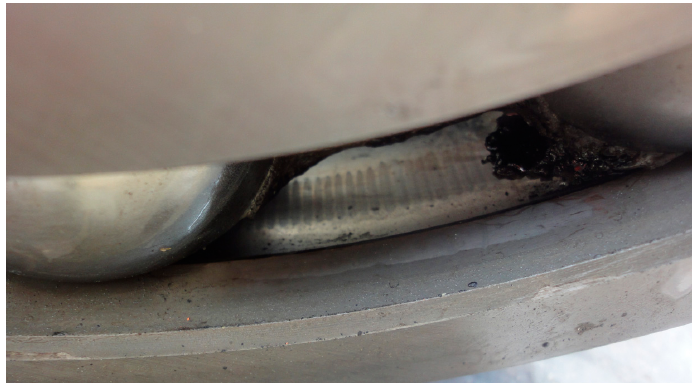
Figure 14. Electric corrosion of a generator bearing.